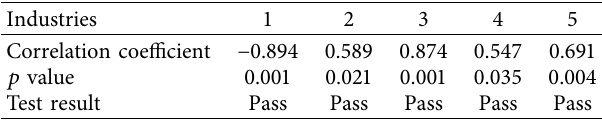
Table 3: Correlation coefficients and significance test